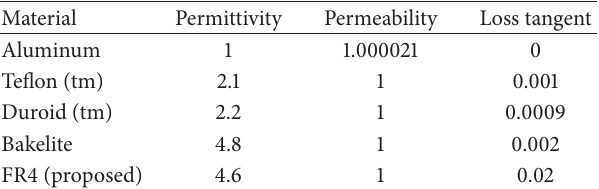
Figure 7: Reflection coefficient with different values of 𝑊 7 . Table 1: Dielectric properties of substrate materials.